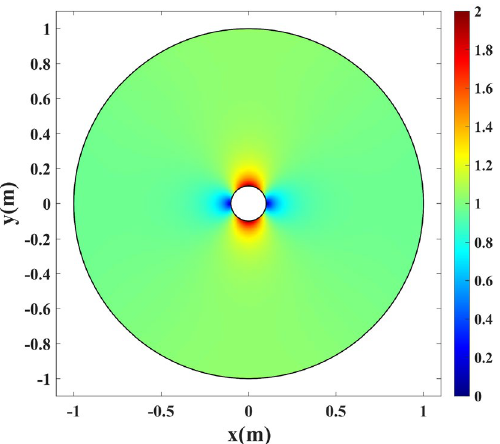
Figure 5. The refractive index profile of the physical space in Fig. 1a with the inner radius of ρ = 0.1 m.